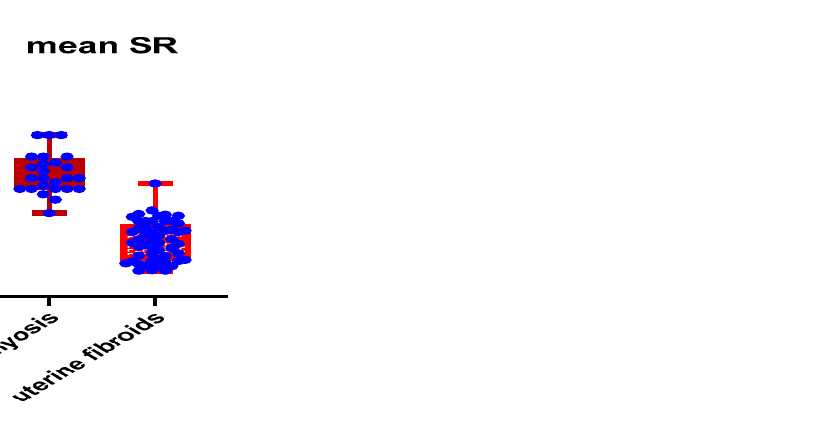
Figure 4. Distribution of mean SR values among the two study groups. Legend: SR = strain ratio.